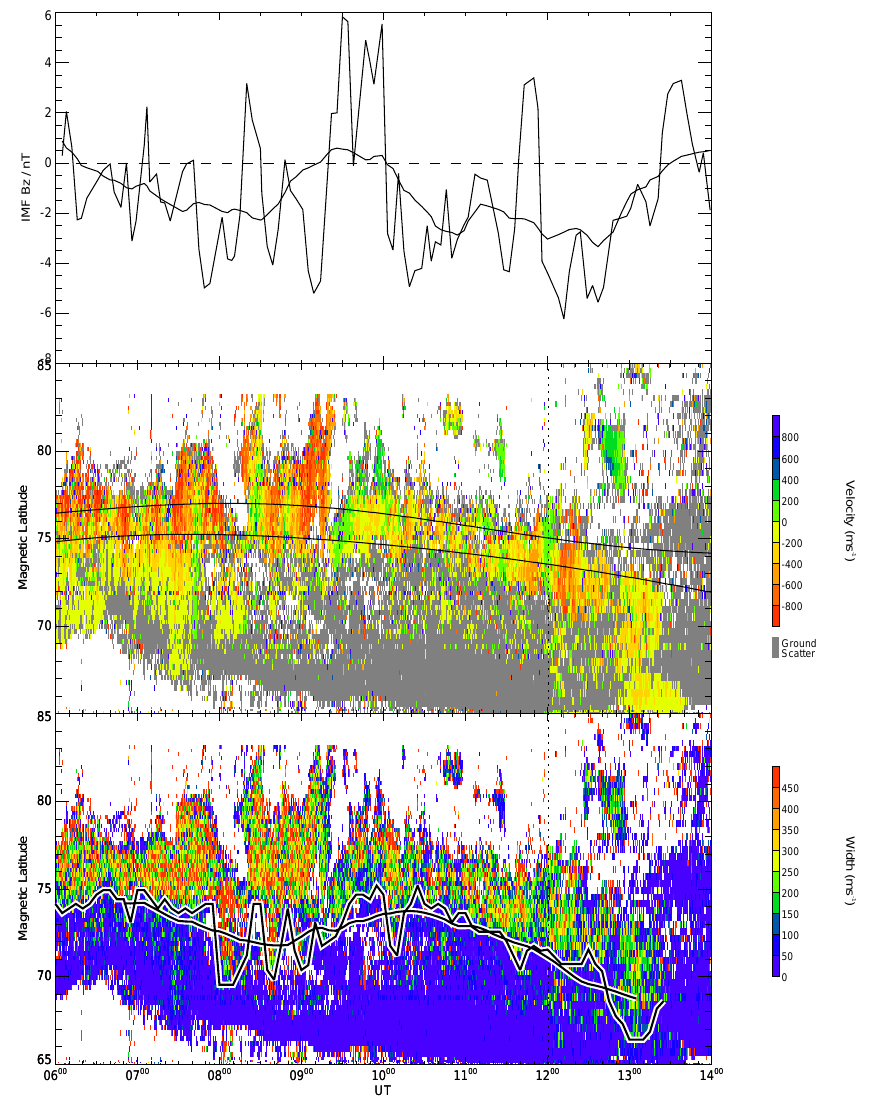
Fig. 1. An example of the identification of the HF radar cusp location and mo- tion from 06:00–14:00 UT on 4 January 2000. The top panel presents the IMF B Z component magnetic field data from ACE, timelagged by 68min (see text for details). Both raw data at a time resolu- tion of 5min, and data smoothed over 50min are shown. The middle panel presents line-of-sight velocity data from beam 9 of the SuperDARN Hankasalmi radar as a function of magnetic latitude and Universal Time. A statistical Feld- stein oval is included for reference. The bottom panel presents beam 9 spectral width data in the same format. The equatorward edge of the region of high spectral width is marked with a line, at a time resolution of 5min, and also smoothed over 50min. Equatorward progression of the HF radar cusp is clearly related to intervals of southward (negative) IMF B Z